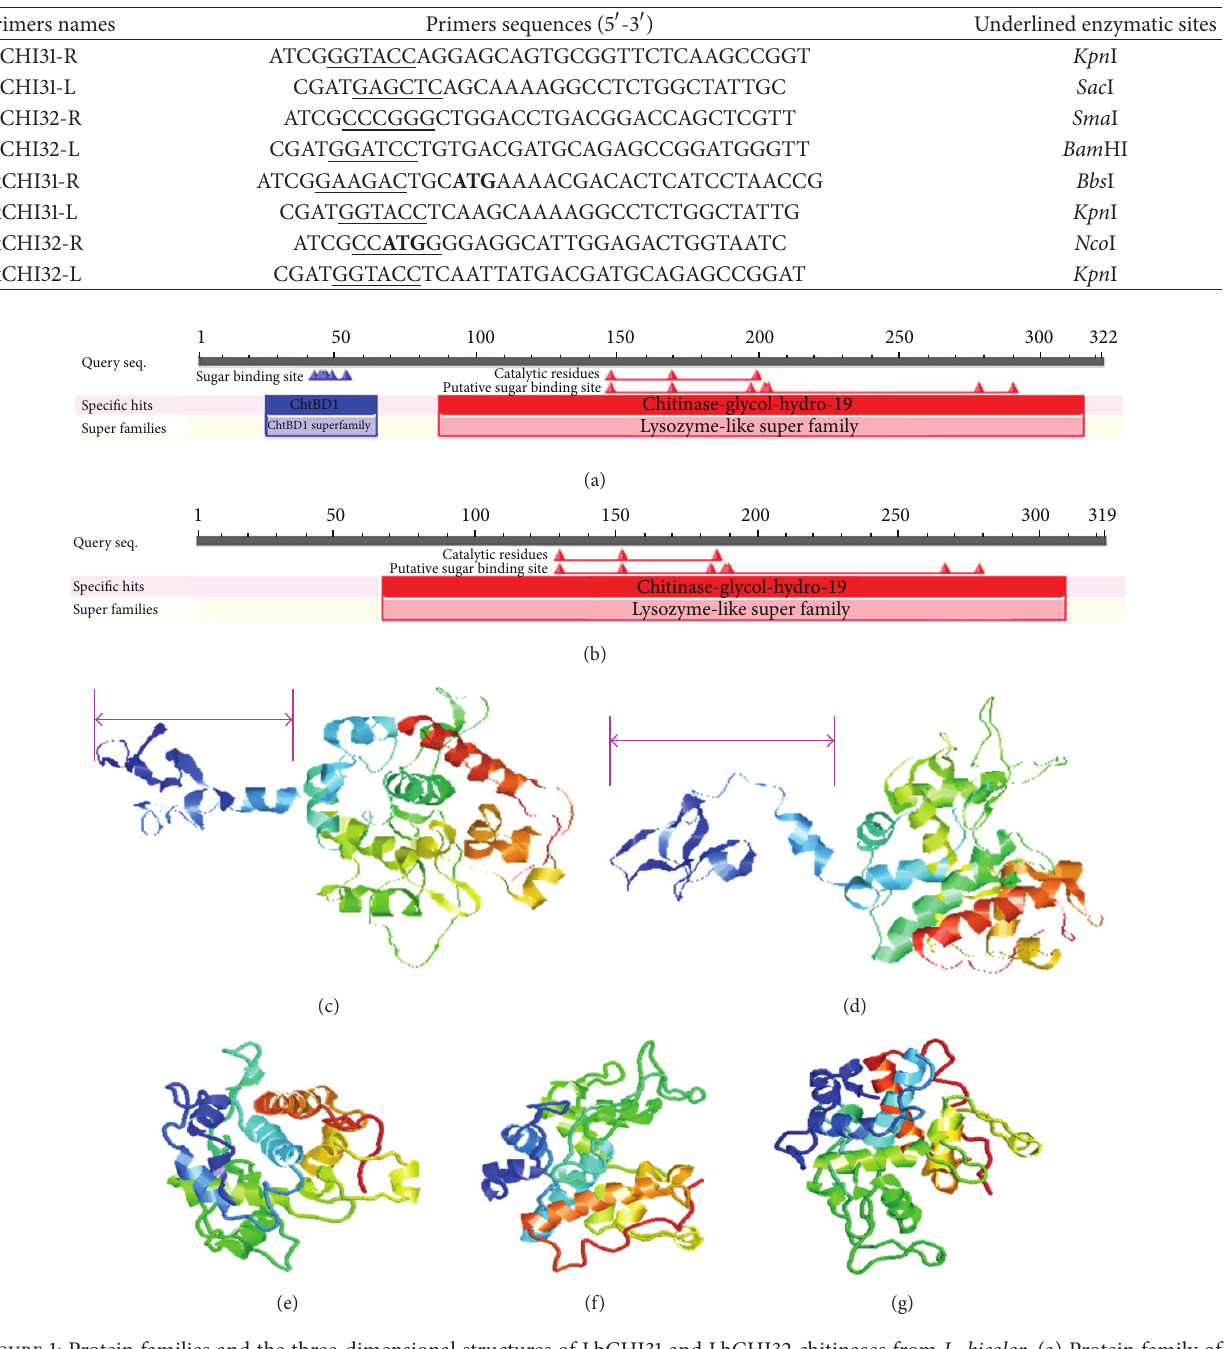
Table 1: The primers used in cloning the LbCHI31 and LbCHI32 genes into prokaryotic intracellular and extracellular expression vectors.